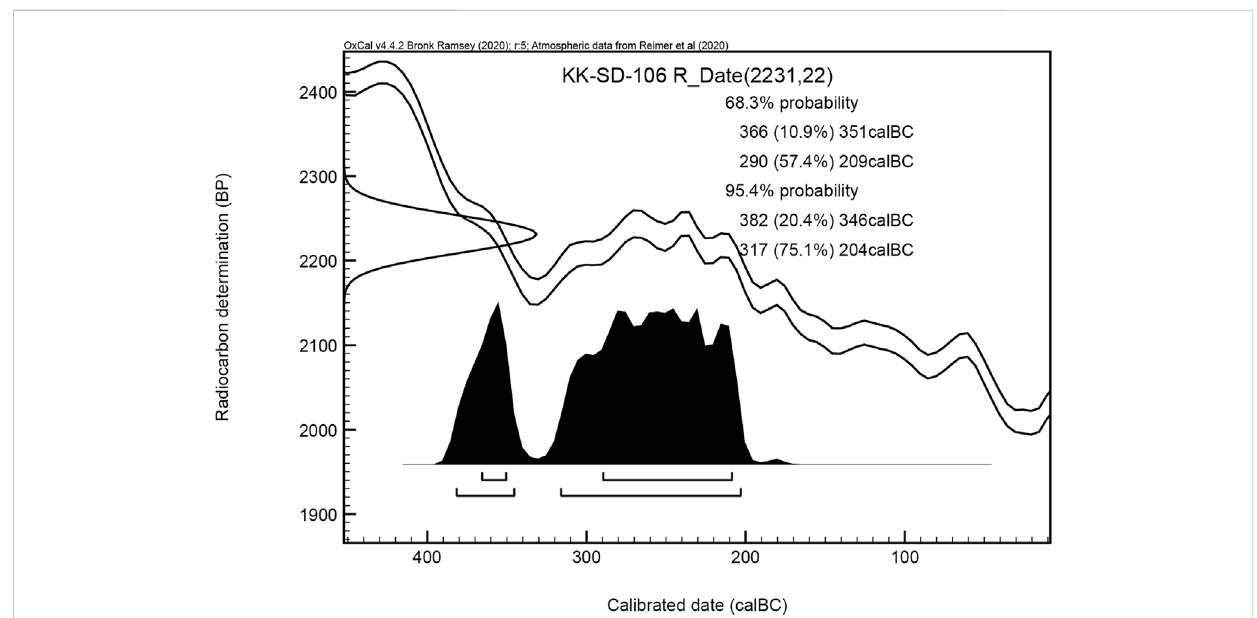
FIGURE 4 Calibrated 14 C date of collagen from immature chicken bone collected from the Karako-Kagi